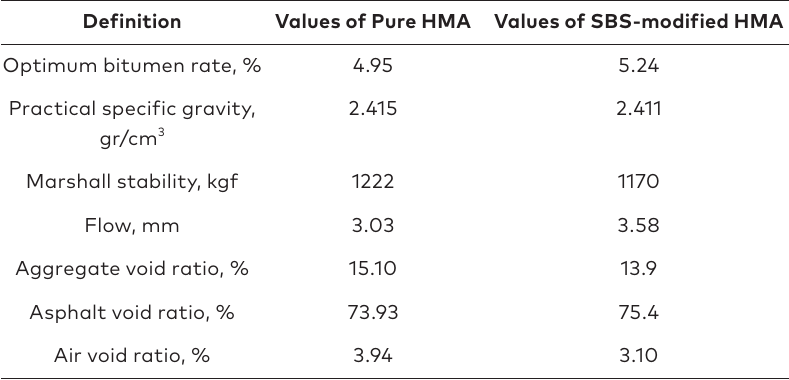
Table 8. Design properties of pure and SBS-modified HMA